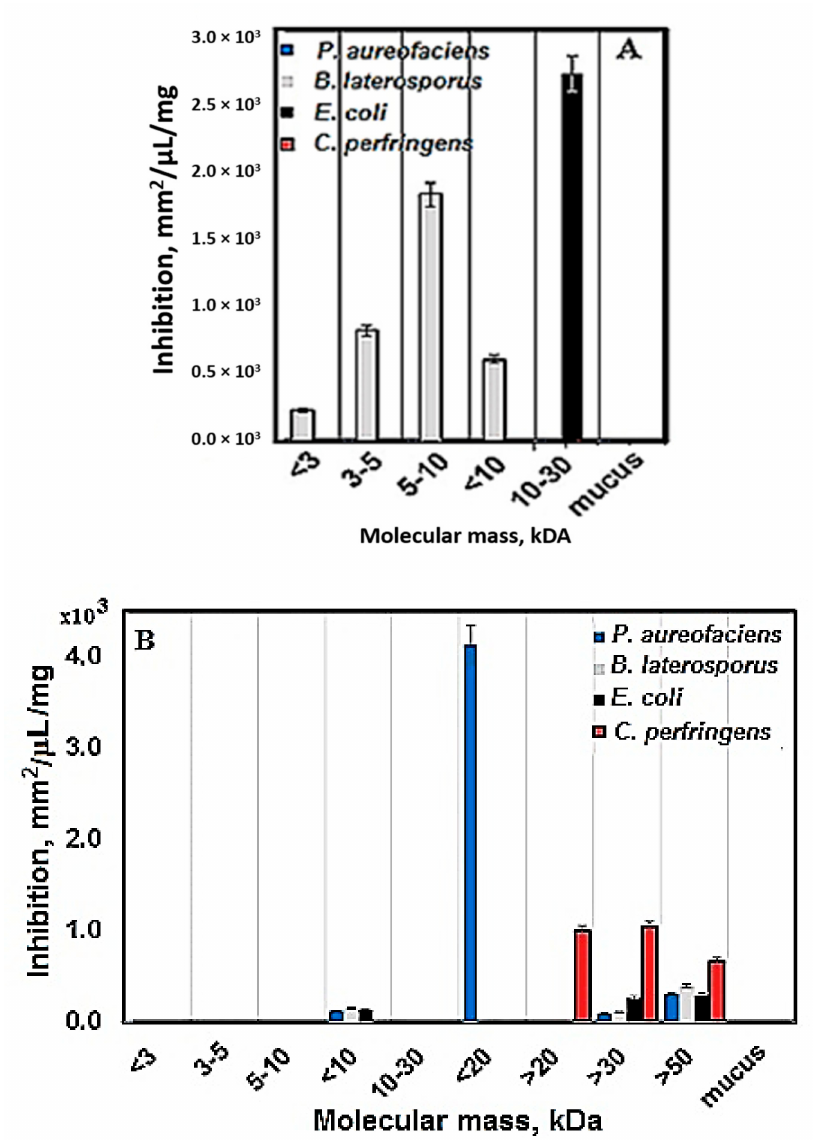
Figure 3. Comparative analysis of the antibacterial activity of Sample 1 (compounds with Mw < 3 kDa), Sample 2 (compounds with Mw 3–5 kDa), Sample 3 (compounds with Mw 5–10 kDa), Sample 4 (compounds with Mw < 10 kDa), Sample 5 (compounds with Mw 10–30 kDa), Sample 6 (compounds with Mw < 20 kDa), Sample 7 (compounds with Mw > 20 kDa), Sample 8 (compounds with Mw > 30 kDa), Sample 9 (compounds with Mw > 50 kDa), and initial mucus extract (mucus) isolated from the garden snail against Gram + bacteria C. perfringens and B. laterosporus and Gram _ bacteria P. aureofaciens and E. coli : ( A ) surface inoculation of bacteria by agar disk-di ff usion assay; ( B ) deep inoculation of bacteria by agar well di ff usion assay. Antibacterial activity was measured in inhibition (mm 2 / µ L / mg Pr). Comparative analysis of the antibacterial activity of di ff erent samples isolated from mucus of the garden snail C. aspersum upon deep inoculation of bacteria reveals that Sample 6 with